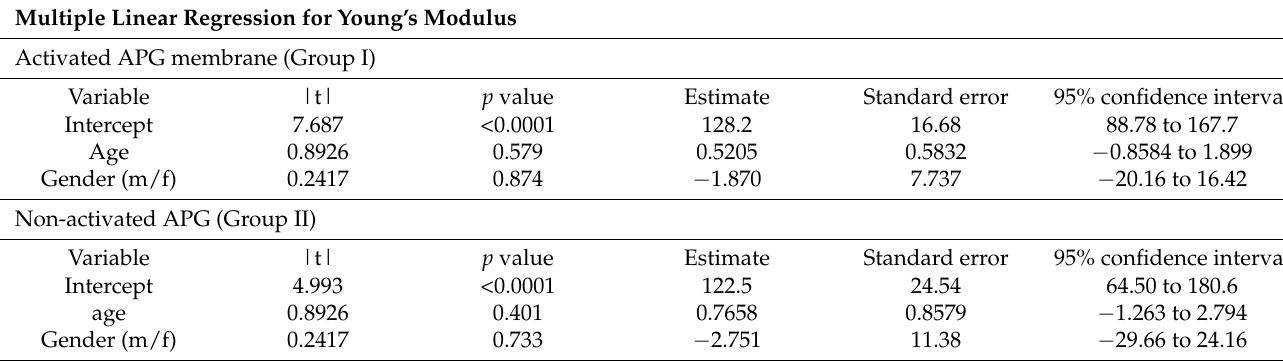
Table 3. Multiple linear regression analysis for Young’s